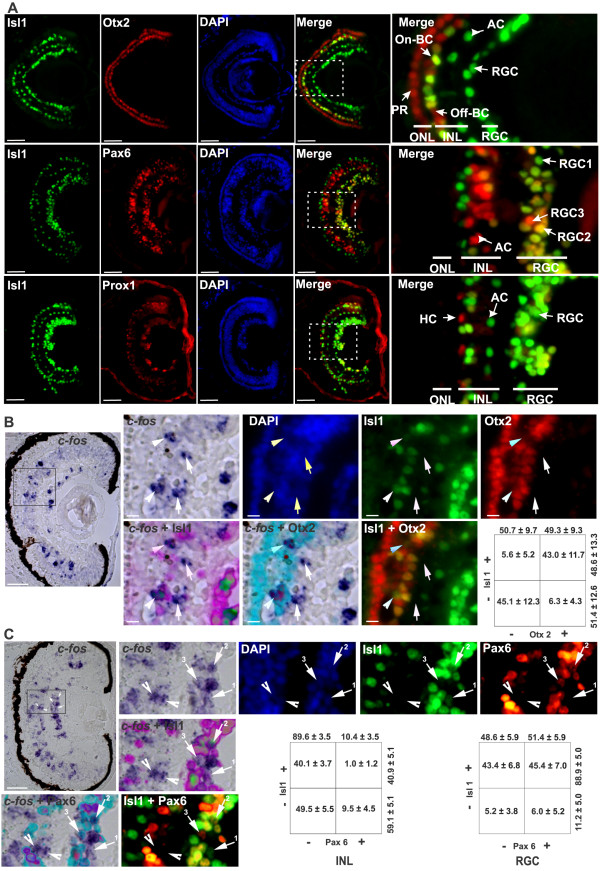
Distinct cell types induce c-fos expression in response to light. (A) Transverse Stage 42 retinal sections co-immunolabeled for Isl1 (green), and either Otx2 (top), Pax6 (middle), or Prox1 (bottom) (red). Higher magnification of a merged picture (right column) and DAPI staining (middle column; blue). The Isl1 antibody recognized On-BCs and ACs in the inner nuclear layer (INL), and RGCs in the RGC layer. Otx2 stained PRs in the outer nuclear layer (ONL) and On-BCs (Otx+/Isl1+) and Off-BCs (Otx+ / Isl1−) cells. Pax6 identified ACs in the INL, and RGCs. Three populations of cells in the RGC layer were defined by Pax6 and Isl1 expression: Isl1+ / Pax6− (RGC1; green), Isl1+ / Pax6+ (RGC2; yellow) and Isl1− / Pax6+ (RGC3; red). Prox1+ HCs were in the outer region of the INL. (B) Light induced c-fos in On-BCs. c-fos mRNA in central retinal sections of dark-reared Stage 42 embryos exposed to light (2500 lux) for 30 minutes, followed by immunohistochemistry against Isl1 (green) or Otx2 (red), and by DAPI staining (blue). A higher magnification of the region is indicated, and the corresponding merges are shown. Two c-fos+ / Otx2+ / Isl1+ (arrowheads) and two c-fos+ / Otx2− / Isl1− (arrows) cells are indicated. The percentage of c-fos + cells in central retinal sections expressing the corresponding markers (mean ± SD; n = 10 retinas) in the INL is shown in tabular form. (C) Two sub-populations of RGCs expressed c-fos. In situ hybridization against c-fos, immunohistochemistry against Isl1 (green) or Pax6 (red), and DAPI staining (blue). Two c-fos+ / Pax6− / Isl1− cells (arrowhead) in the INL, and three c-fos + cells (arrows) corresponding to RGC1 (Isl1+ / Pax6−), RGC2 (Isl1+ / Pax6+), and RGC3 (Isl1− / Pax6+) are indicated. Scale bar = 50 μm for lower, and 10 μm for higher, magnifications.